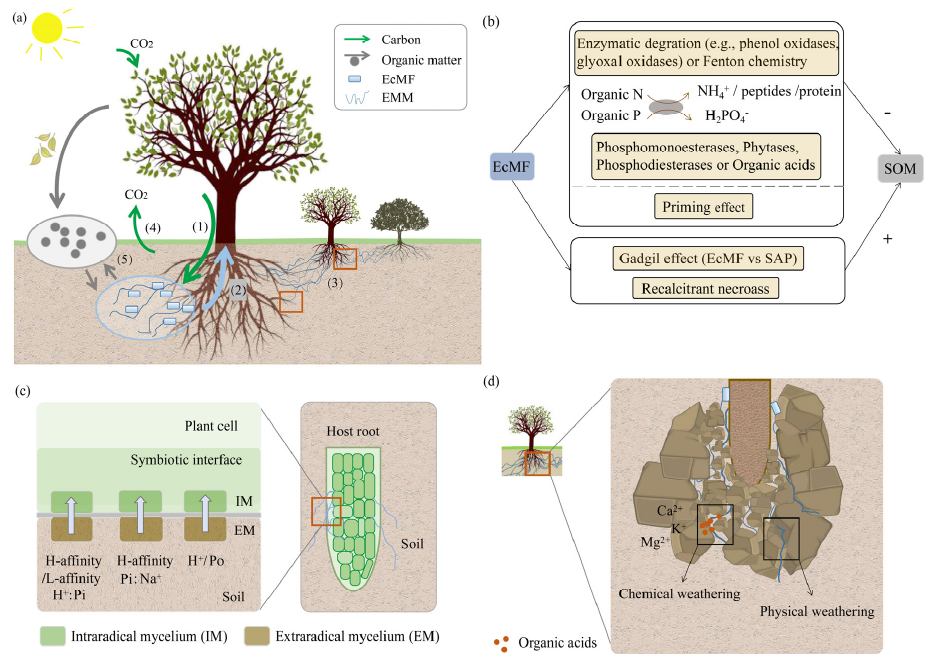
Figure 1. The role of ectomycorrhizal fungi (EcMF) in nutrient cycling: ( a ) Carbon (C) flow through EcMF promotes the turnover of soil organic matter (SOM) and cycling of nutrients [29]. (1) Plant hosts transfer photosynthate to EcMF primarily as simple sugars [5]. (2) EcMF increase the effective absorptive surface area of roots enabling the transfer of nutrients, water, and other soil resources to hosts. (3) Hyphae can form inter- and intraspecific host mycelial networks for the bi-directional exchange of nutrients and carbohydrates [30,31]. (4) Root–mycorrhizal systems are involved in the release of carbon dioxide (CO 2 ) by soil respiration [32]. (5) The turnover of EcMF and fine roots are important sources of labile C and nutrients for microbial processes [29], and the residues of EcMF and the extramatrical mycelium are incorporated into organic matter [33]. ( b ) EcMF participate in the